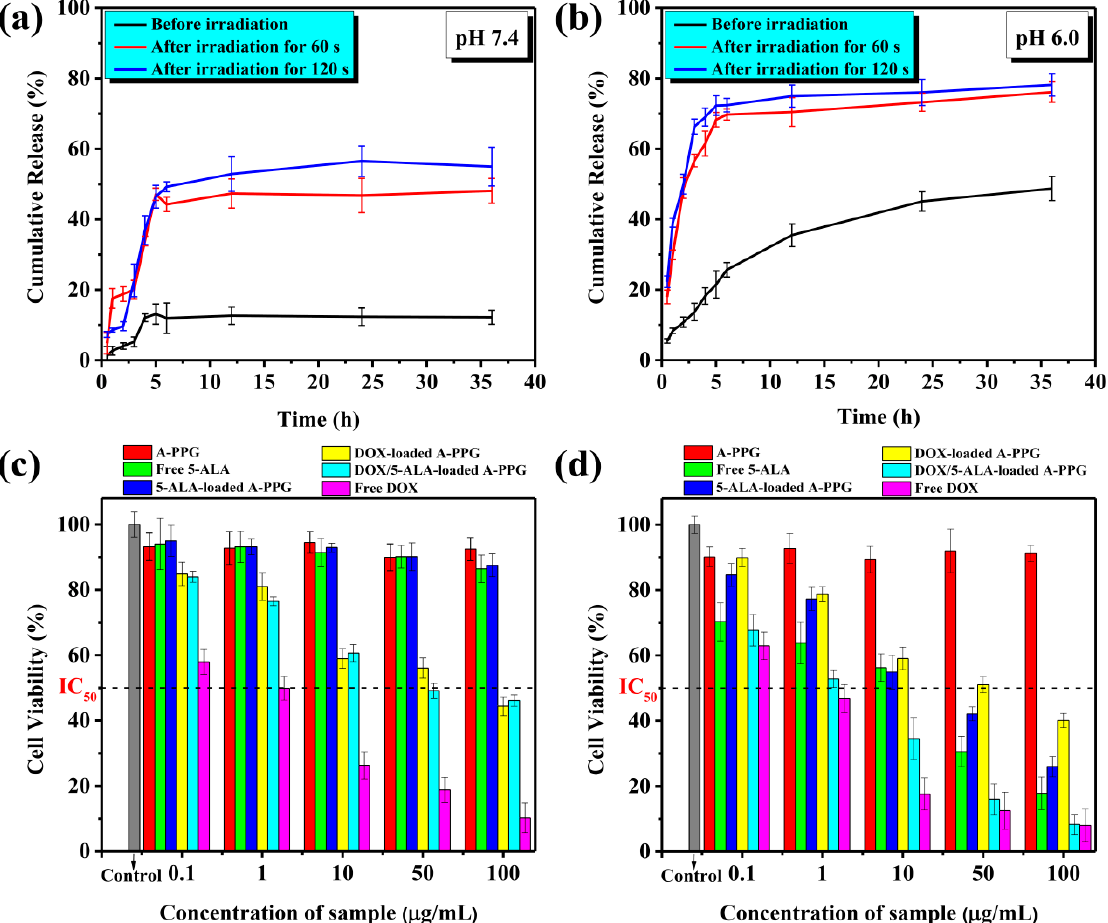
Figure 2. Cumulative DOX release profiles of DOX/5-ALA-loaded A-PPG micelles in PBS before and after irradiation for various periods of time (635 nm light, 60 mW/cm 2 ) at ( a ) pH 7.4 and ( b ) pH 6.0. In vitro cell viability of HeLa cells at 24 h after incubation with A-PPG micelles, DOX, 5-ALA, and single-cargo or double-cargo DOX/5-ALA-loaded A-PPG micelles ( c ) before irradiation and ( d ) after irradiation.